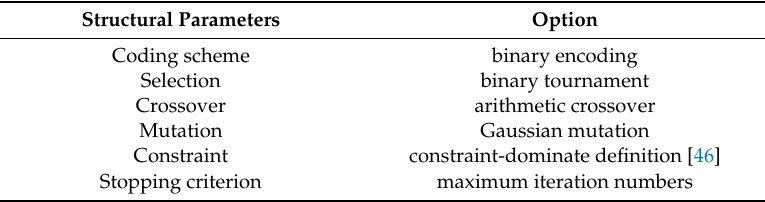
Table A3. Structural parameters of optimization algorithm.